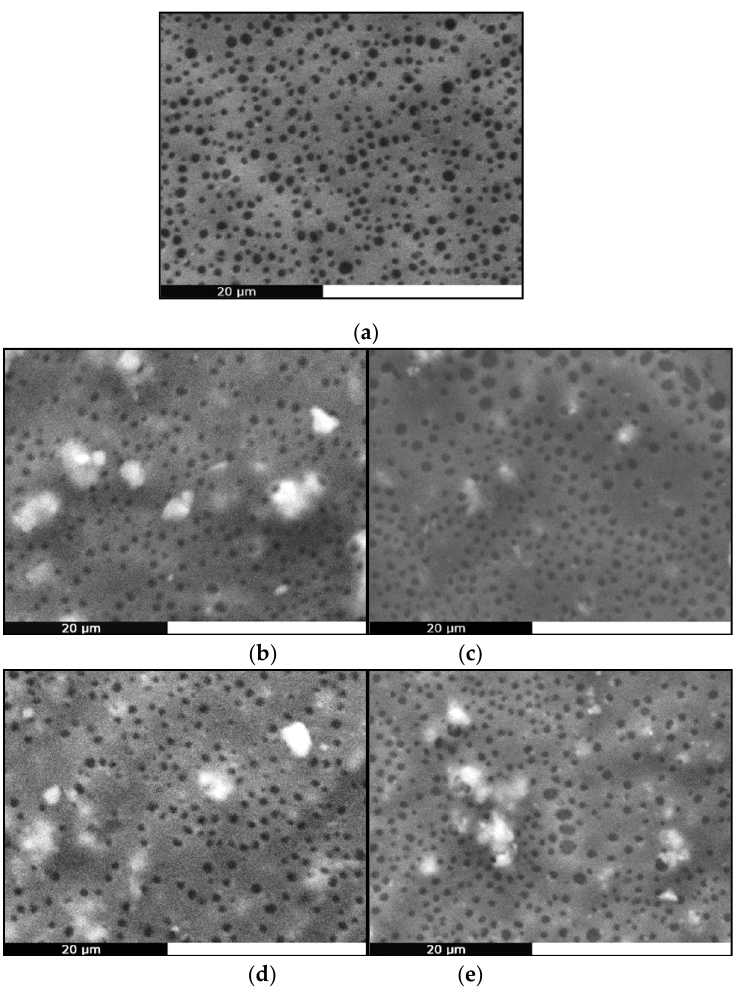
Figure 9. SEM micrographs of ( a ) PCL, ( b ) PCL/CaBG, ( c ) PCL/SrBG, ( d ) PCL/CaBG-Iba, ( e ) PCL/SrBG-Iba.